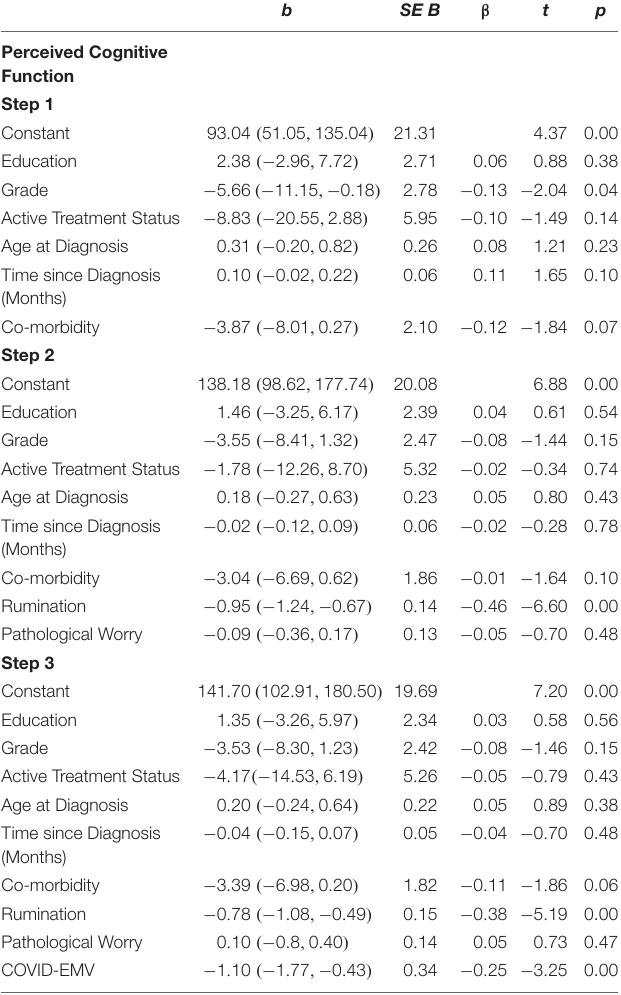
TABLE 6 | Hierarchical regression analyses for the predictors of perceived cognitive function. b SE B β